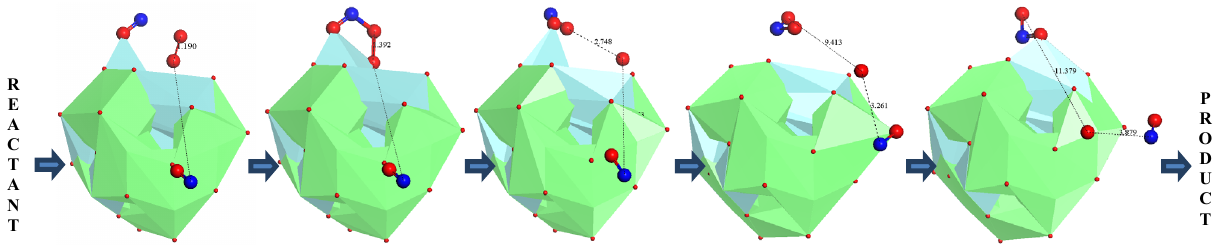
Figure 8. Reaction path corresponding to Equation (3) for the YSZ/Au model cluster at the PWC/DNP theory level. ● : Y, ● : Zr, ● : O, and ● : N.